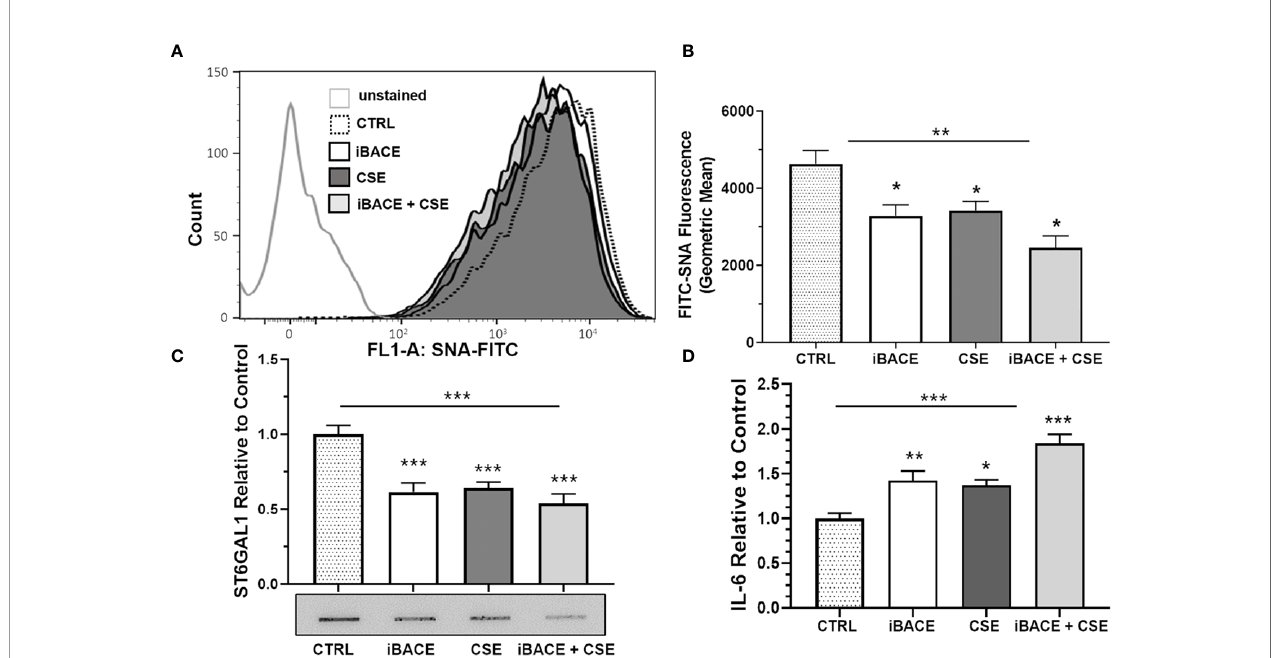
FIGURE 5 | Inhibition of ST6GAL1 secretion reduces a 2-6 sialylation and increases IL-6 secretion similar to CSE. (A) Flow cytometric analysis of a 2-6 sialylation using SNA-FITC labeling of HBECs (CTRL, ST6GAL1 KD, and ST6GAL1 OE) following treatment with and without iBACE and CSE for 72 hours. (B) 10,000 events were collected for each group, analyzed, and shown as the geometric mean. (C) Densitometry and a representative slot blot of secreted ST6GAL1 collected from conditioned medium following incubation with iBACE, CSE, or both. As a loading control, the supernatants were normalized to total cellular protein. (D) IL-6 secretion was determined from conditioned medium using an ELISA kit to the IL-6 ligand following same treatments as (C) . Experiments were performed in triplicate using three separate experiments. SNA, Sambucus Nigra Lectin; CTRL, control; iBACE, beta-site amyloid precursor protein cleaving enzyme 1 inhibitor; and CSE, cigarette smoke extract. All bar graphs are means ± SEM with *p < 0.05, **p < 0.01 and ***p <